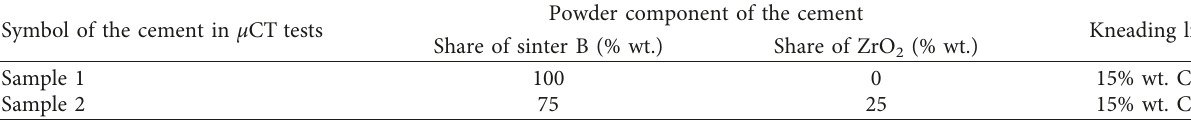
Table 6: Symbols and composition of cements undergoing the µ CT test. Powder component of the cement Symbol of the cement in μ CT tests Share of sinter B (% wt.) Share of ZrO 2 (% wt.)